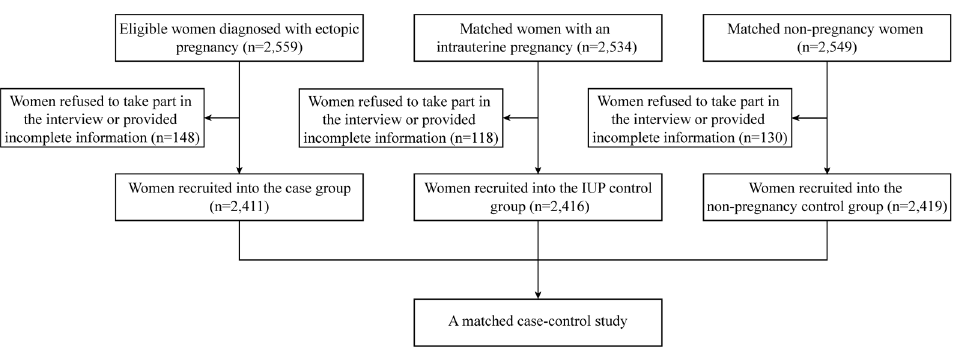
Figure 2. The recruitment profile for this